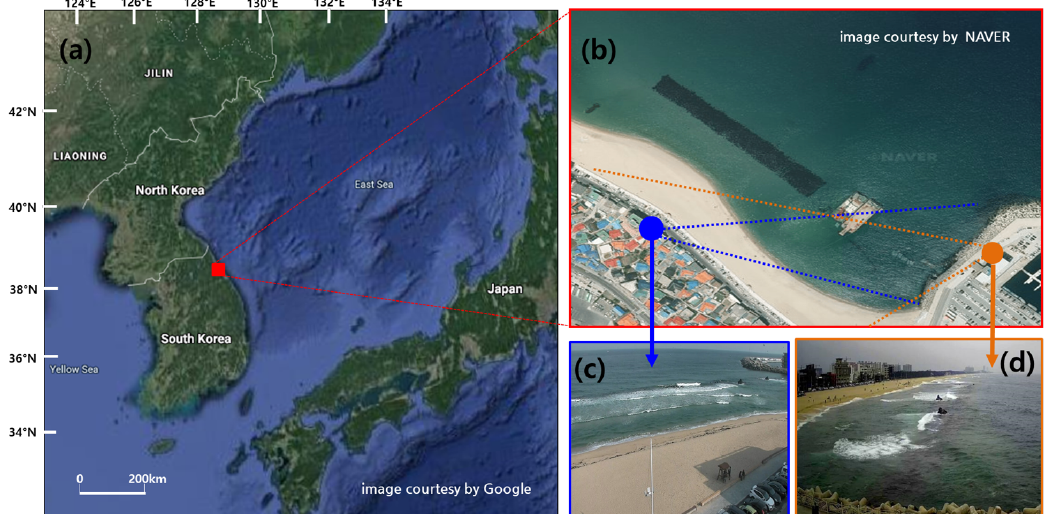
Figure 4. Study area of Anmok Beach located in north–eastern South Korea ( a ). The CCTV video system was installed at two locations ( b ); one for the unpaired raindrops dataset (blue circle) and one for the paired raindrop dataset (green circle). The locations for collecting the unpaired- and paired-image datasets are shown in ( c , d ), respectively. Dark pixels in ( b ) indicate the area where the submerged breakwater is installed.